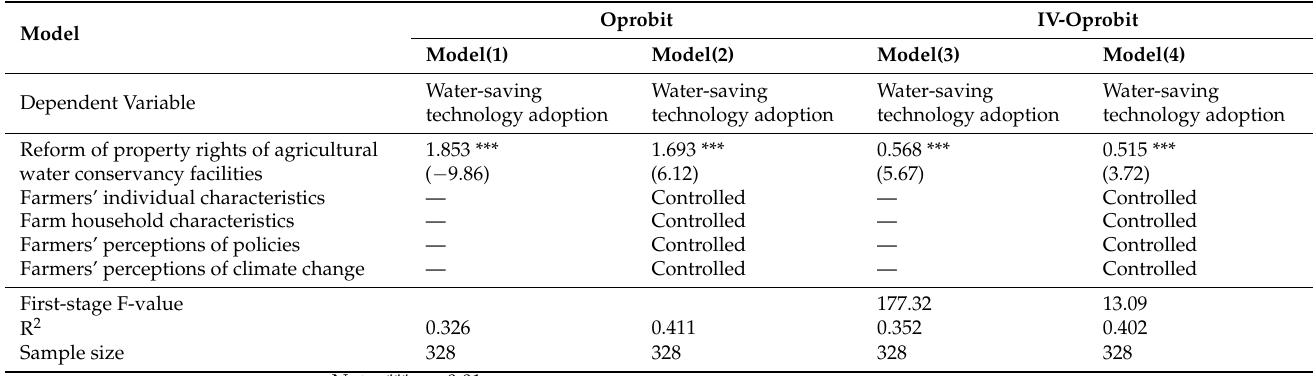
Table 4. Regression results of the impact of the reform of property rights of agricultural water facilities on farmers’ adoption behavior of water-saving